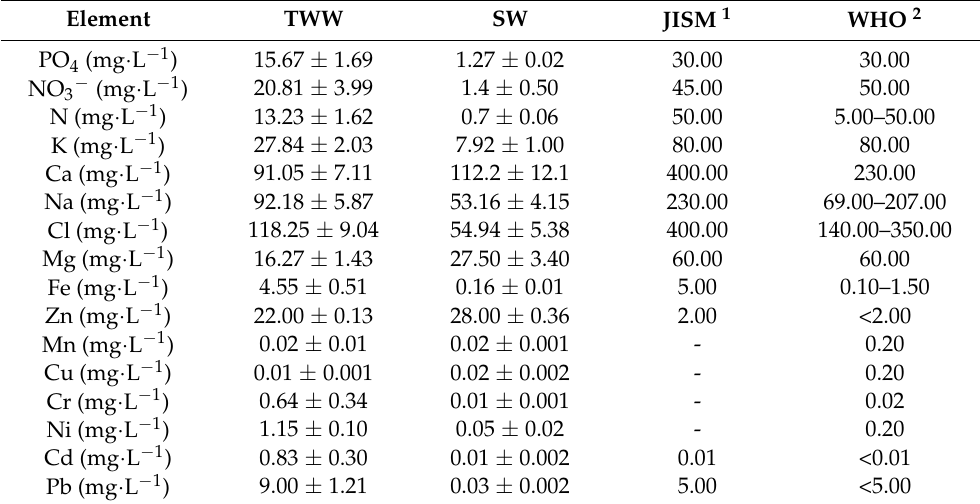
Table 3. Chemical analysis of irrigation waters from both Treated wastewater (TWW) and spring water (SW) sources compared with allowable Jordanian (JISM) and WHO standard limits for irrigation water. The data are averages ± SD ( n =